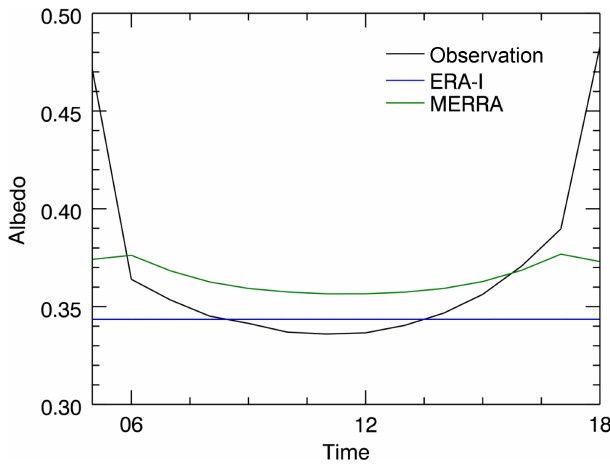
Figure 3. Diurnal cycle of mean surface albedo at